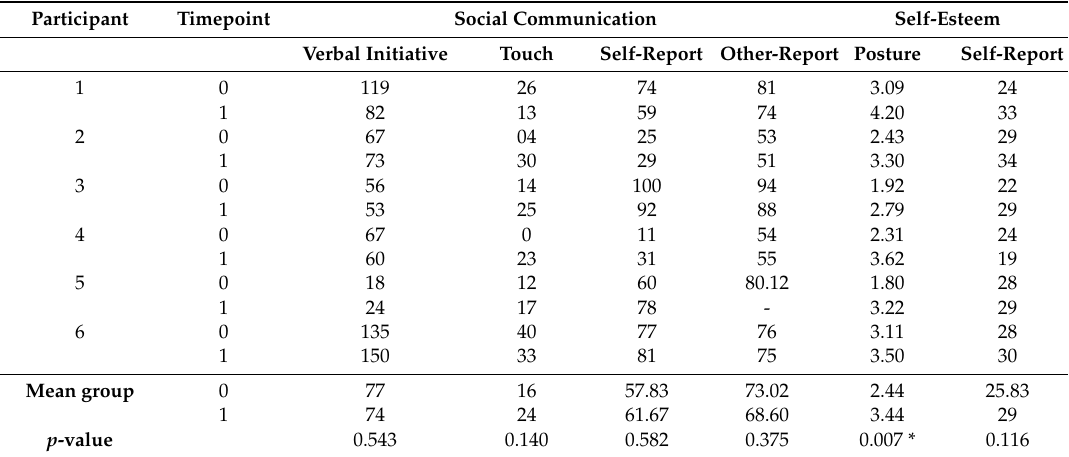
Table 2. Baseline and post-treatment scores.